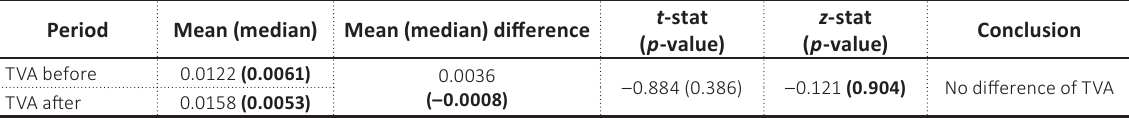
Table 7. Summary of third hypothesis testing results